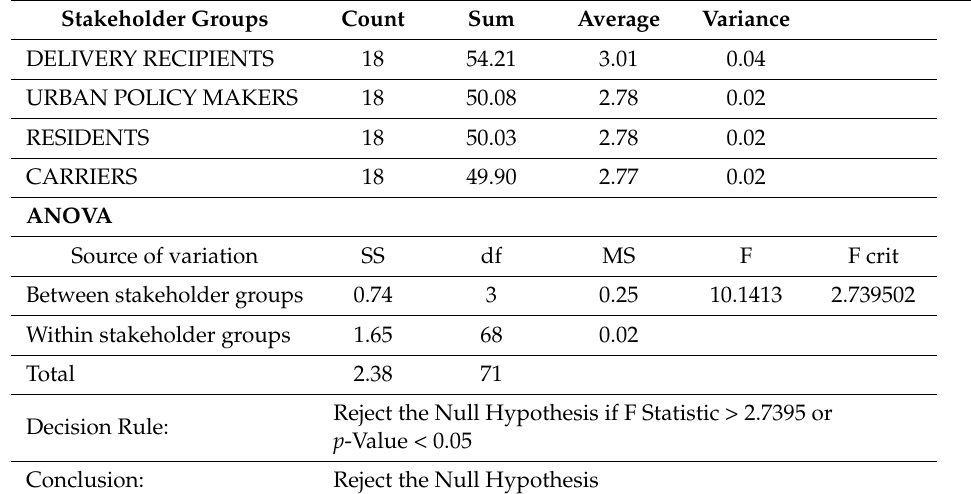
Table 3. Application of ANOVA test according to